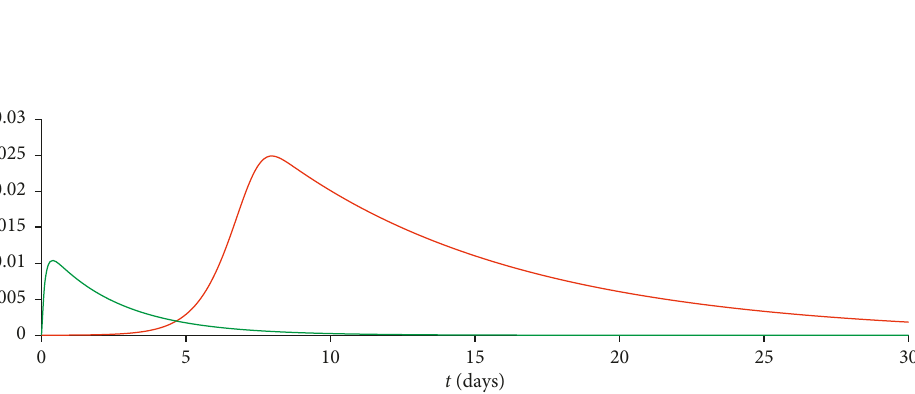
Figure 4: Dynamics of the immune response: rate of the destroyed